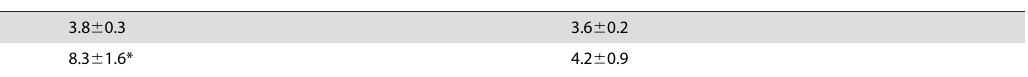
Groups Average number of nonsynonymous SNPs Average number of synonymous SNPs Other genes on Ch.